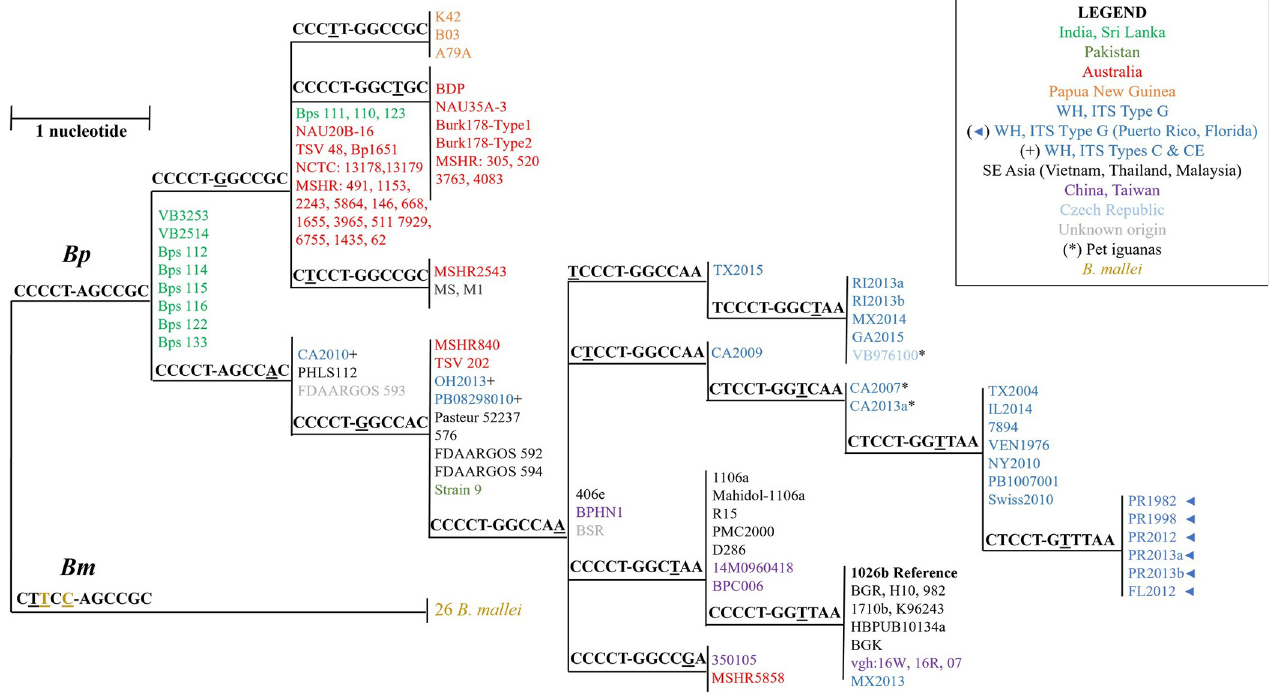
Fig 2. DLST SNP-based phylogeographic tree for the initial set of B . pseudomallei (n = 101) and B . mallei (n = 26). Each branch represents isolates with a distinct 11-nucleotide SNP signature determined by DLST. B . pseudomallei strains are color-coded by geographic origin and SNPs used to differentiate B . mallei strains are shown in dark